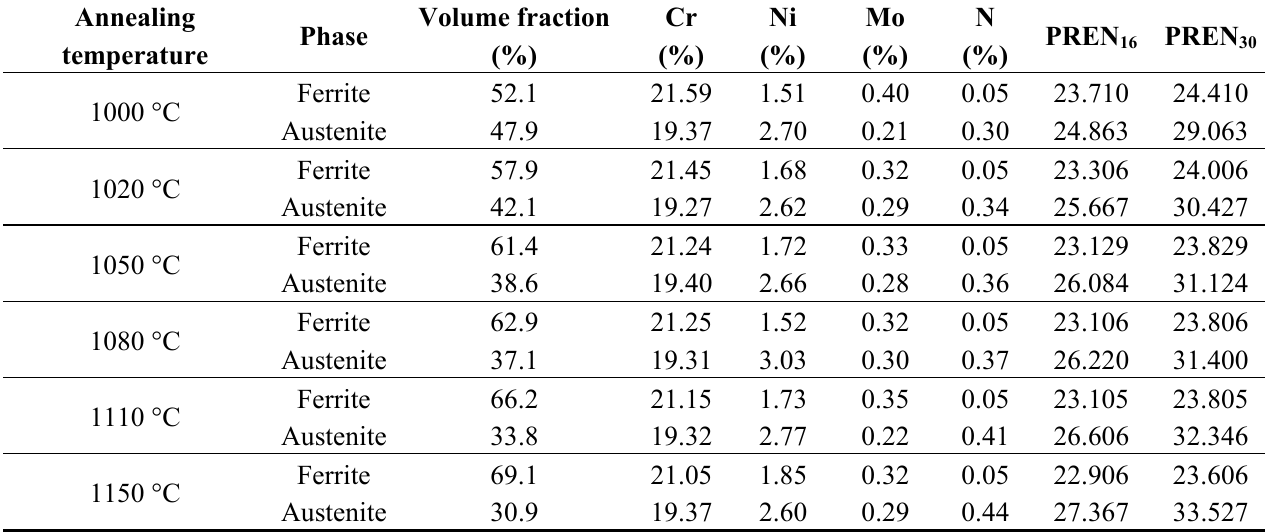
Table 2. Chemical composition and pitting resistance equivalent number (PREN) of the two phases for specimens annealed at different temperatures, obtained by